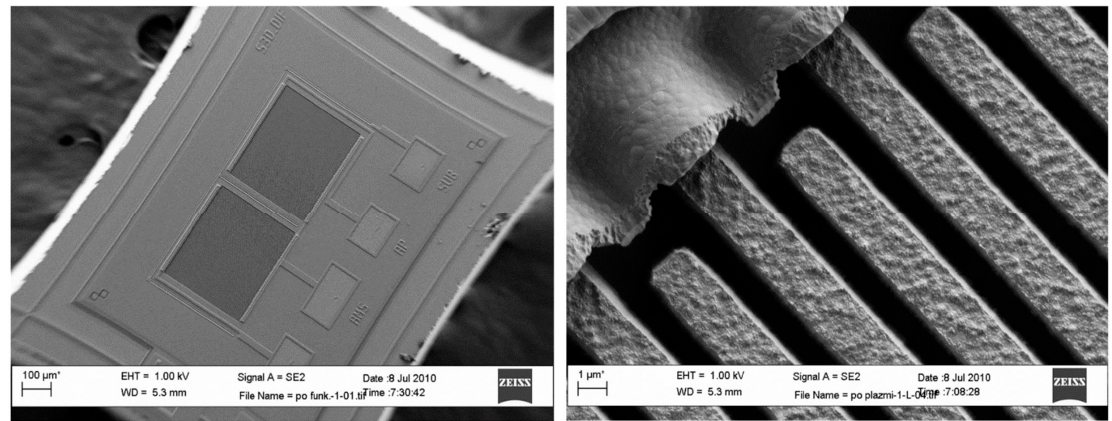
Figure 1. SEM image of a differential pair of COMB micro-capacitor.